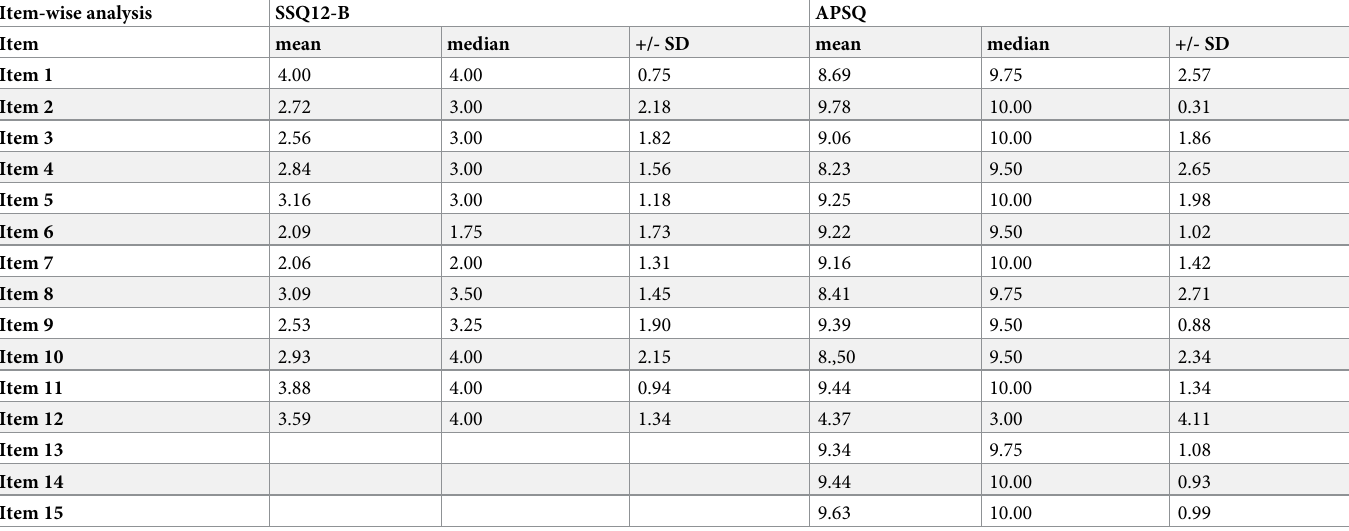
Table 2. Item-wise analysis of the SSQ12-B and